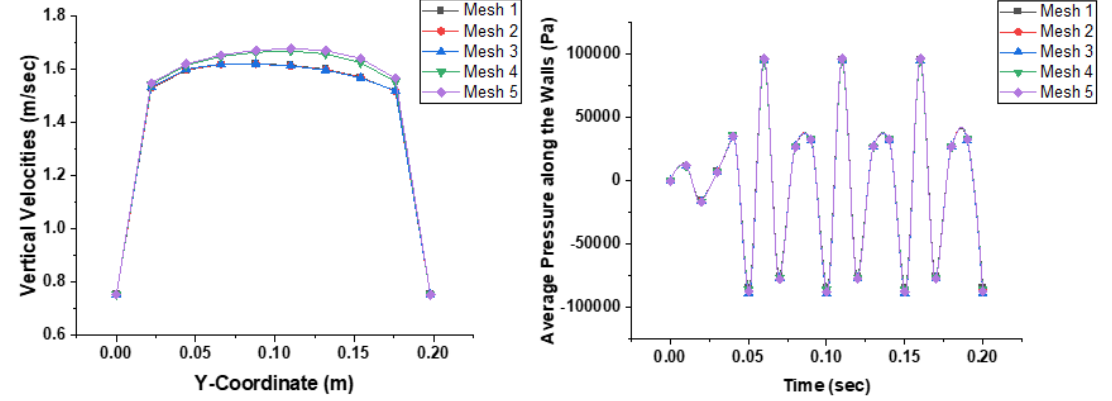
Figure 5. Mesh independence test for different meshes.